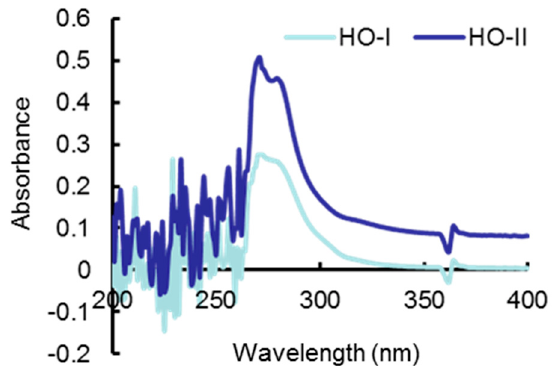
Figure 4. Horse oil absorbs UVB rays. The UVB absorption spectrum of horse oil was determined by UV scanning at 200–400 nm. The maximum absorbance of horse oil appeared at 271 nm, and the absorbance values of HO-I or HO-II were 0.2756 and 0.5067, respectively.